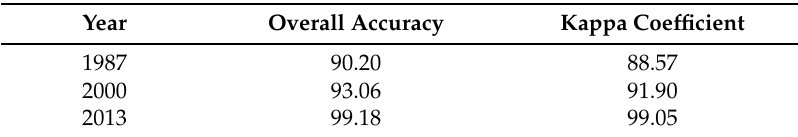
Table 3. Overall Accuracy and Kappa Coefficient of the LULC